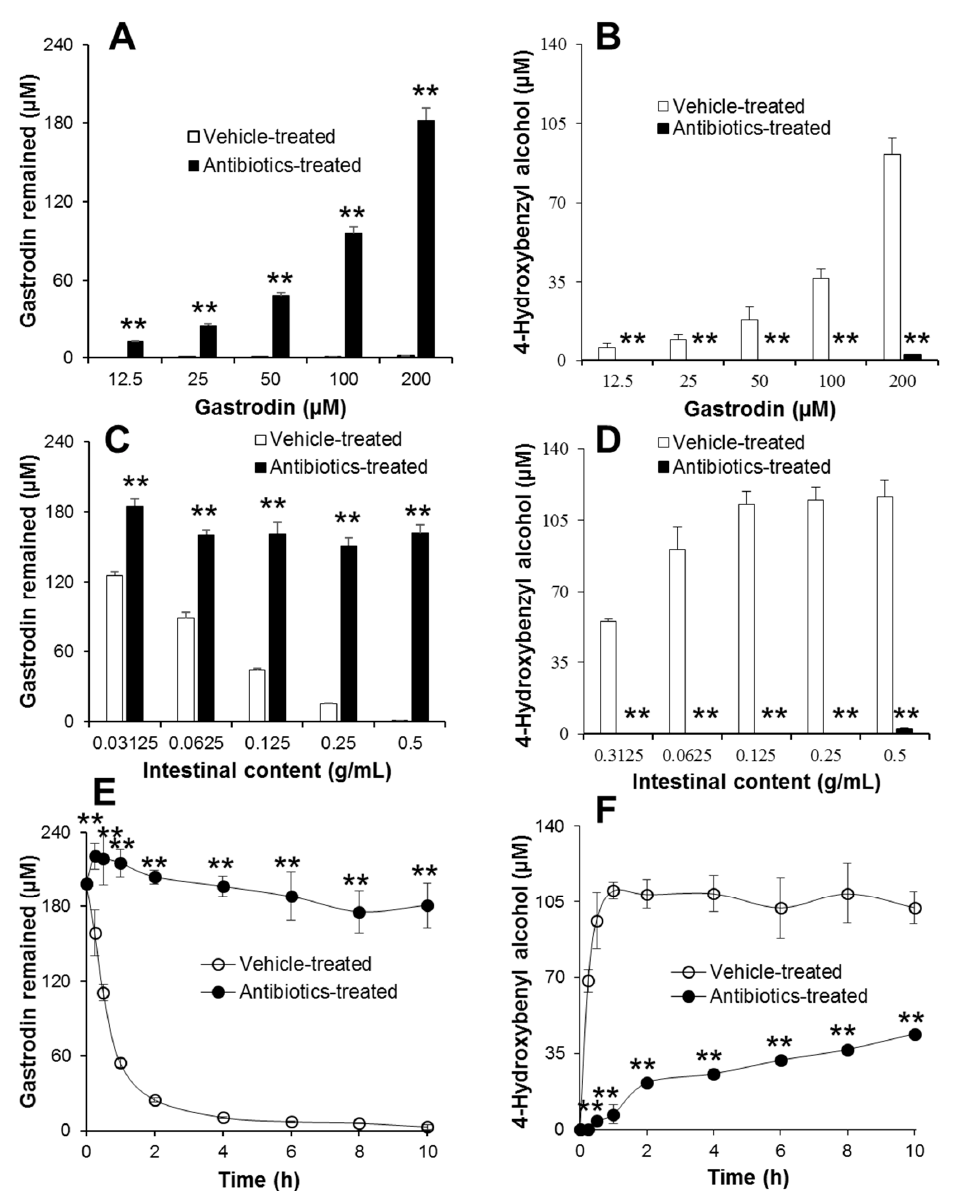
Figure 4. In vitro metabolism of gastrodin by intestinal microbiota. ( A,B ) Concentration-dependent metabolism of gastrodin. Following incubation of various concentrations of gastrodin with 0.5 g/mL intestinal contents prepared from vehicle- and antibiotics-treated rats at 37°C for 4 h, gastrodin and 4-HBA were extracted with methanol containing 10 ng/mL tolbutamide and analyzed by LC-MS/MS. Asterisks (**) indicate the value is significantly different from corresponding control at p < 0.01. ( C,D ) Intestinal content-dependent metabolism of gastrodin. Following incubation of 200 µM of gastrodin with various concentrations of intestinal contents prepared from vehicle- and antibiotics-treated rats at 37 ° C for 4 h, gastrodin and 4-HBA were extracted with methanol containing 10 ng/mL tolbutamide and analyzed by LC-MS/MS. Asterisks (**) indicate the value is significantly different from corresponding control at p < 0.01. ( E,F ) Metabolism of gastrodin over time by intestinal microbiota. Following incubation of 200 µM gastrodin with 0.5 g/mL intestinal contents prepared from vehicle- and antibiotics-treated rats at 37 °C for various time points, gastrodin and 4-HBA were extracted with methanol containing 10 ng/mL tolbutamide and analyzed by LC-MS/MS. Asterisks (**) indicate the value is significantly different from corresponding controls at p < 0.01.